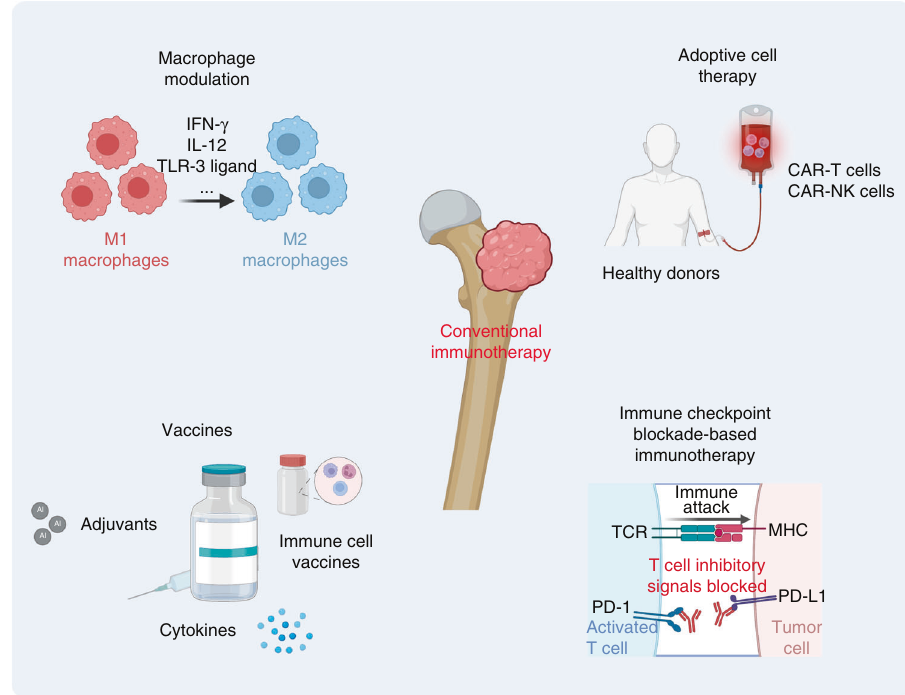
Fig. 5 Schematic illustration of current immunotherapy strategies for osteosarcoma